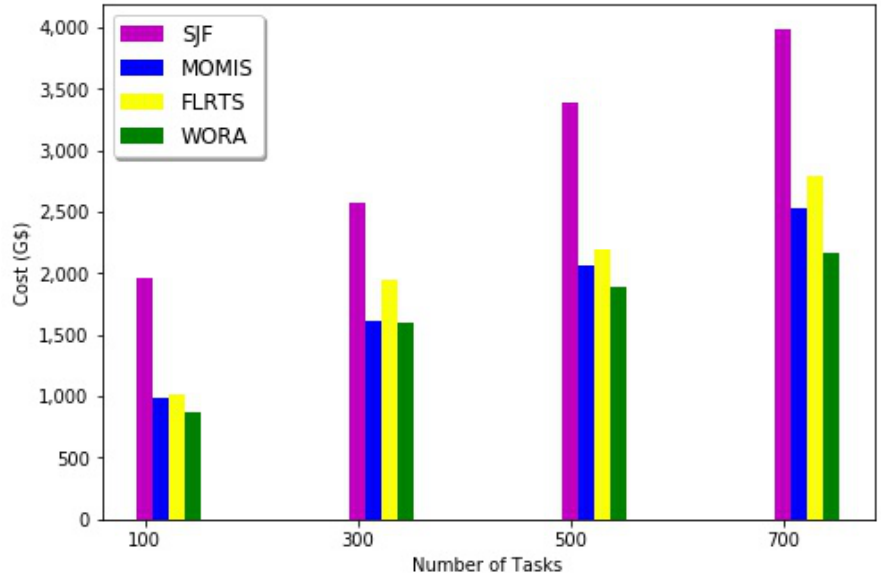
Figure 11. Computation of cost of tasks with 15 fog nodes.